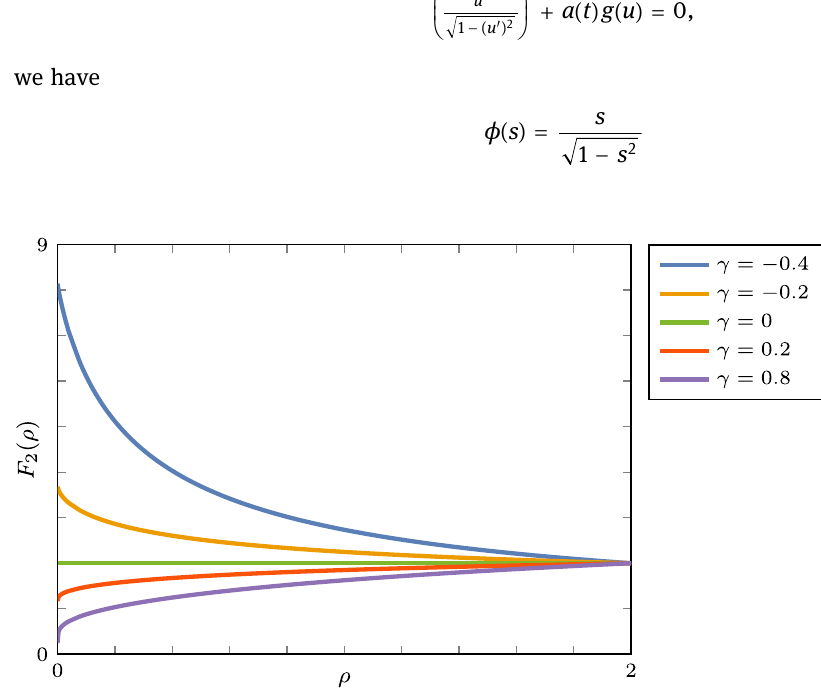
Figure 1: Graphs of F 2 ( ρ ) for γ ∈ { − 0.4, − 0.2, 0, 0.2, 0.8 } , with a + = 1 and a − =